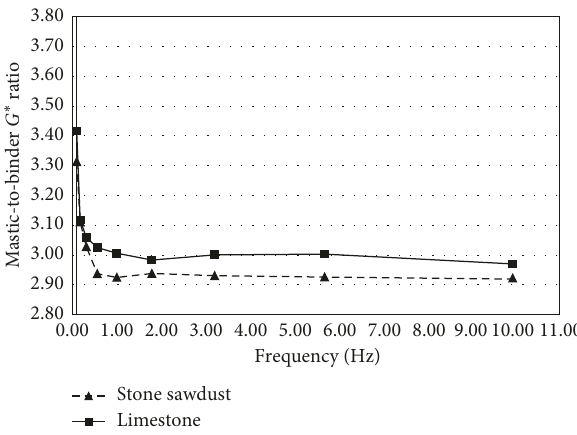
Stone sawdust Figure 23: Mastic-to-binder modulus ratio versus frequency ( T 40 ° C and VR 0.30). (cid:30) (cid:30)